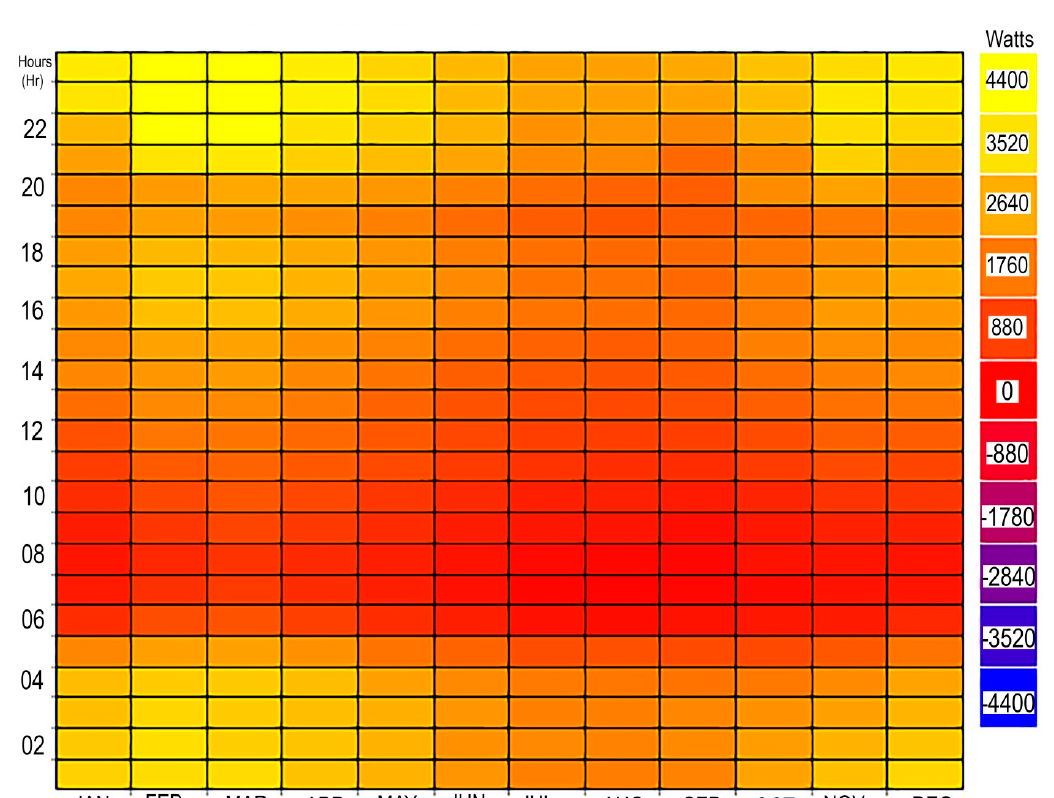
Figure 7. Average daily hourly temperatures in the study area. Indirect Solar Figure 8 reports the simulation of indirect solar. The graph indicates that lowest gains occur between 6:00–16:00 (mainly 0–0.04 KW). Thereafter, heat gain increases. A further analysis (Figure 9) shows the effect of indirect solar on the four sides of the compound house. This is shown in in